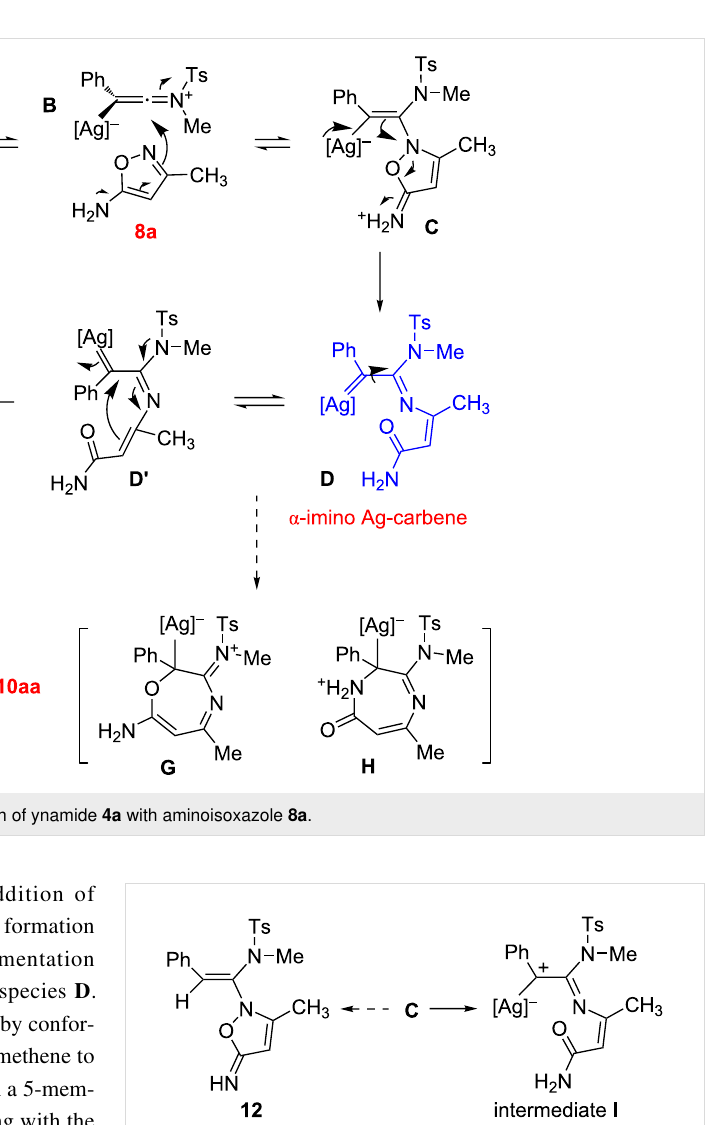
Scheme 6: Possible reaction routes of intermediate C